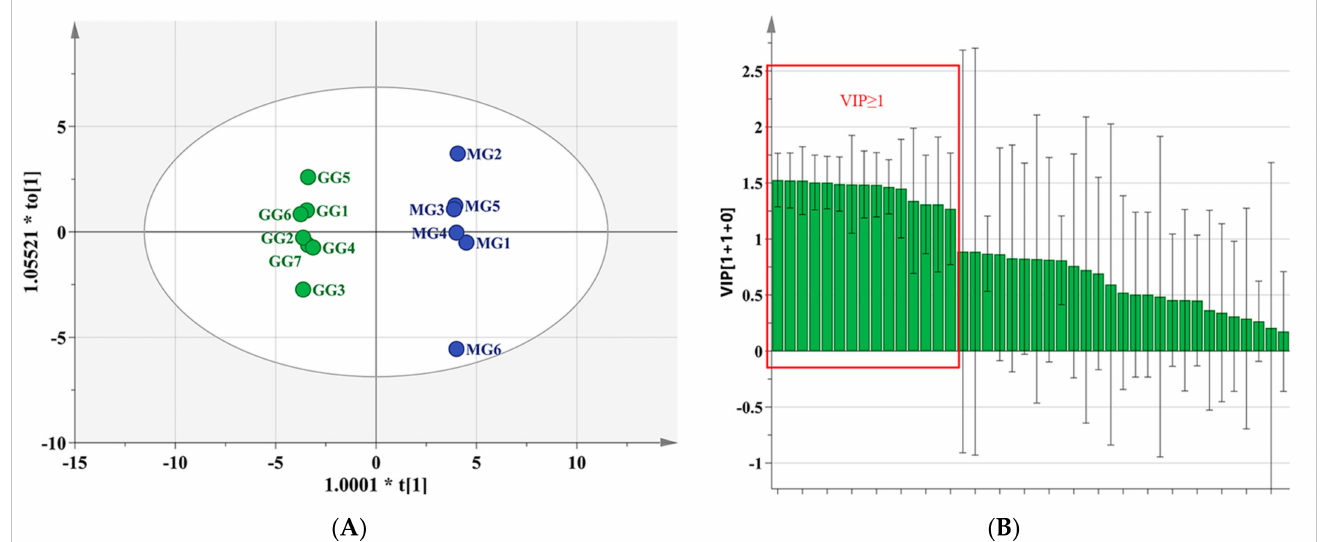
Figure 3. ( A ) OPLS-DA score plots of the 13 batches of Ginseng ; ( B ) The value of VIP of constituents (* p <